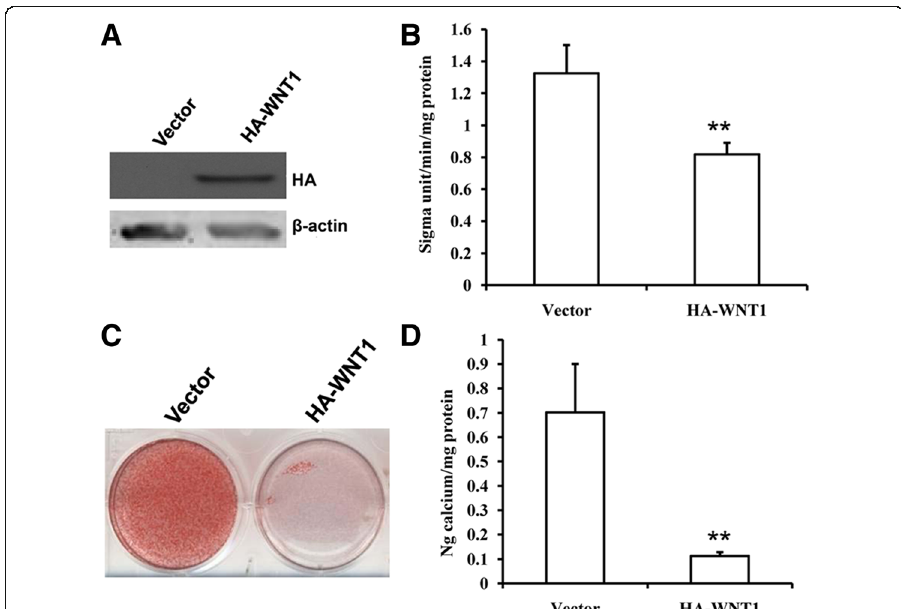
Fig. 5 Overexpression of WNT1 inhibited the osteogenic differentiation capacity of SCAPs. a Western blot results confirmed the overexpression of WNT1 via retrovirus infection of SCAPs. Beta-actin was used as an internal control. b ALP activity. c Alizarin Red staining. d Quantitative analysis of calcium concentration. Student ’ s t test was performed to determine statistical significance. All error bars represent SD ( n = 3). ** p ≤ 0.01. (sigma unit: unit of measurement for ALP